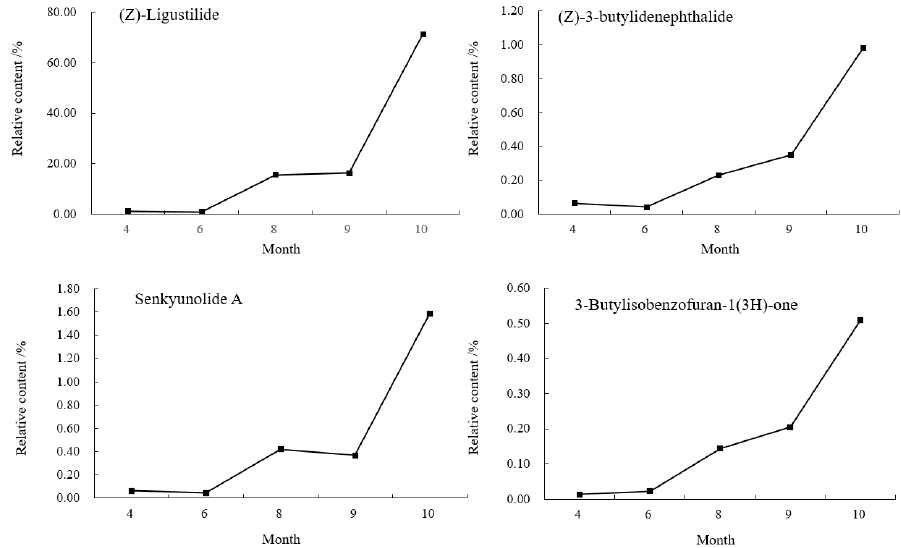
Figure 5. Changes of chemical components in the body of A. sinensis in different periods. 3.3. Analysis of Chemical Components in the Tail of A. sinensis at Different Periods The GC-MS chromatogram of A. sinensis of the tail of A. sinensis in different periods was shown in Figure 6. The chemical composition and relative concentrations were obtained using the peak area normalization method (Table 3).